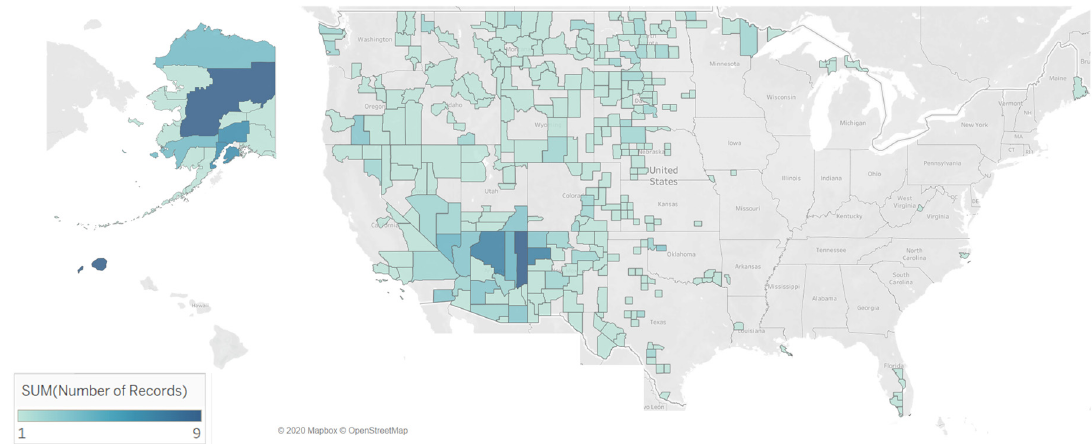
Figure 8. Geographic maps representing counties in the United States with census tracts designated as low access at 20 miles. A low-access tract at 20 miles is a rural tract with at least 500 people, or 33 percent of the population, living more than 20 miles from the nearest supermarket, supercenter or large grocery store. A function of this knowledge visualization is attention to the presence and location of counties. The color intensity is based on the number of records (census tracts) in the county flagged for low access at 20 miles.